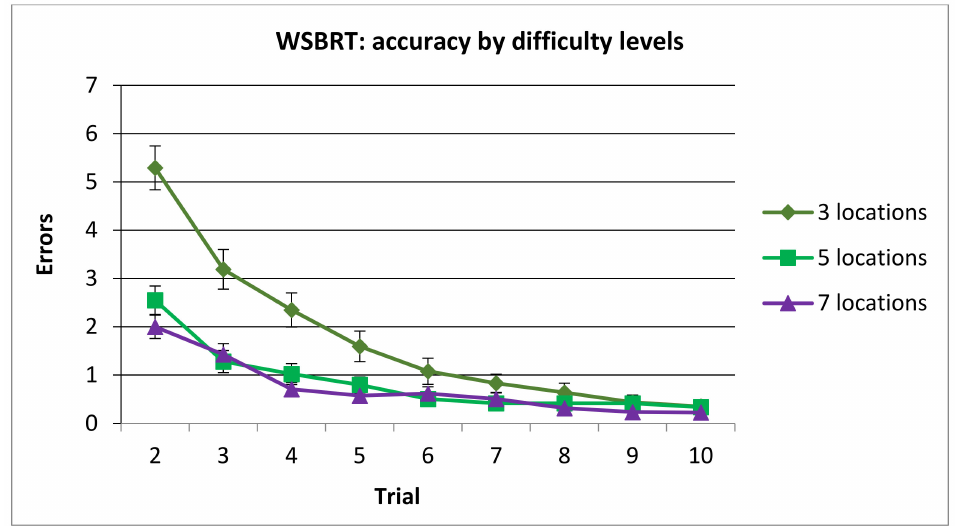
Figure 5. Mean number of errors committed in the WSBRT according to the difficulty. Note that trial 1 was removed from analysis since performance was at random. (Mean ± SEM).